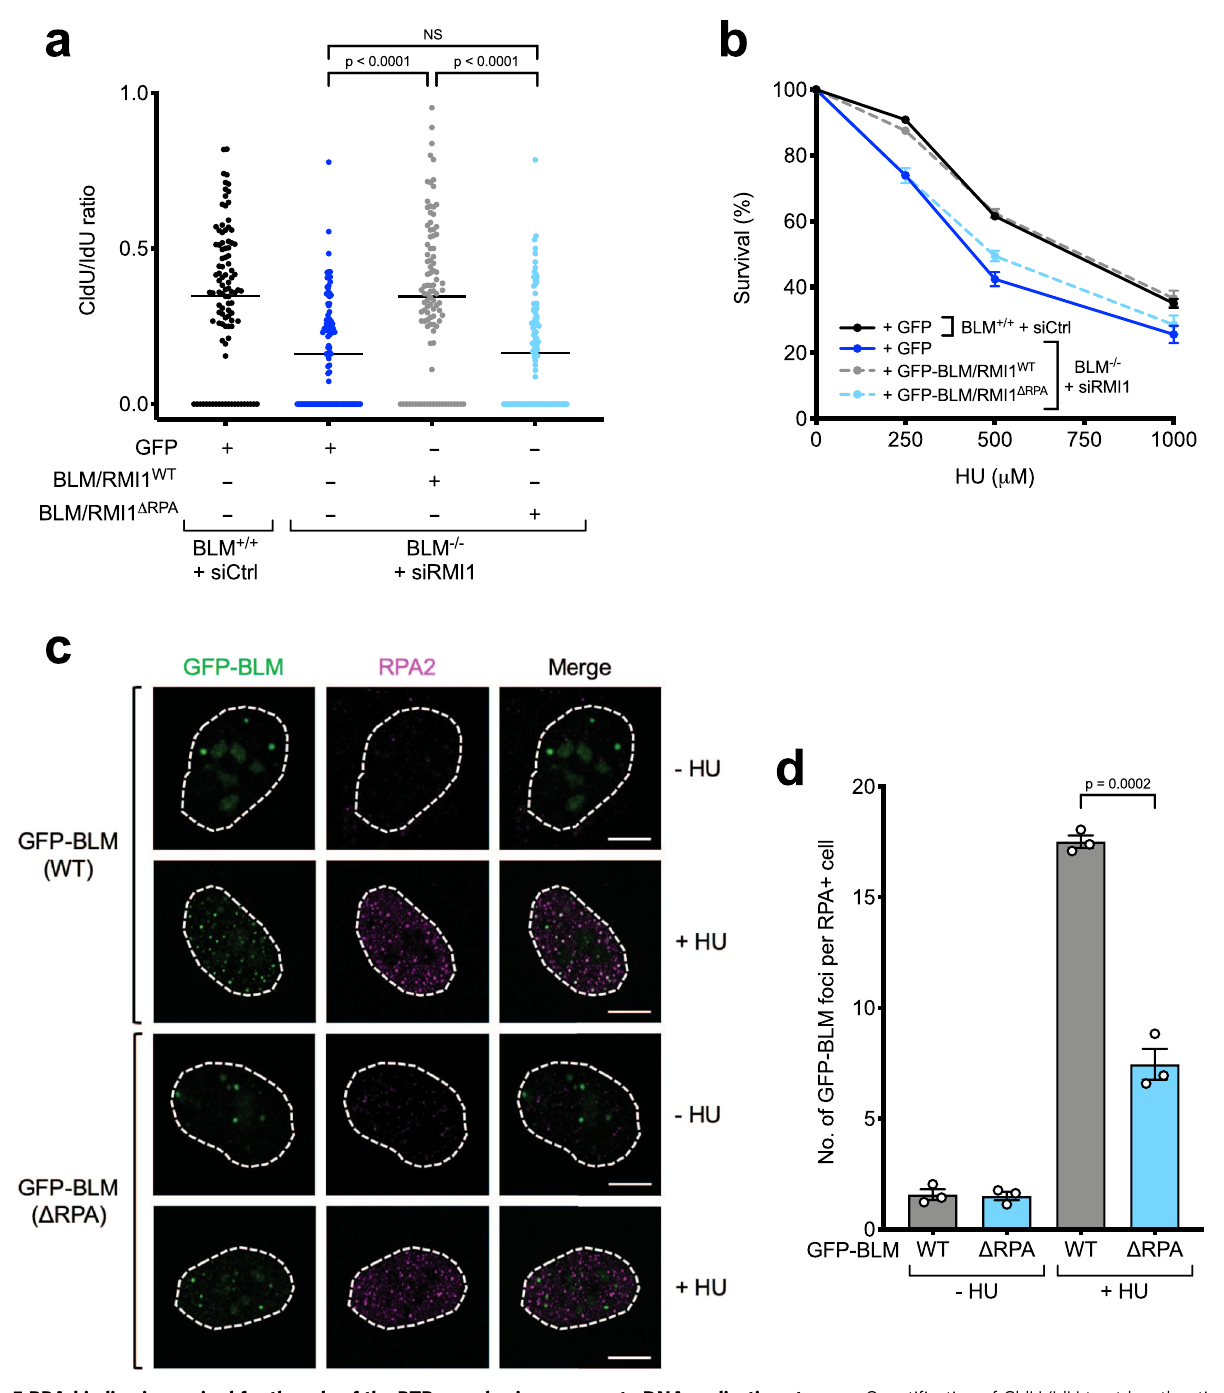
Fig. 5 RPA-binding is required for the role of the BTR complex in response to DNA replication stress. a Quanti fi cation of CldU/IdU tract length ratios in DNA fi ber assays showing that RPA-binding by BLM and RMI1 is required for replication fork restart ( n = 3, one representative experiment shown). At least 100 DNA fi bers were analyzed per sample. Signi fi cance was determined using the two-sided Mann – Whitney U test. b Colony survival assays showing RPA-binding by BLM and RMI1 is required for HU resistance ( n = 3, error bars denote SEM). Cells were treated with the indicated doses of HU for 24h. c Immuno fl uorescence confocal microscopy images of the indicated proteins, demonstrating that the RPA-binding BLM mutant ( Δ RPA) is defective in its ability to form foci that colocalize with RPA2 in response to replication stress. Cells were treated where indicated with 2mM HU for 24h. d Quanti fi cation of the number of WT and Δ RPA GFP-BLM foci in the experiment shown in c ). Signi fi cance was determined using the two-sided unpaired t test ( n = 3, error bars denote